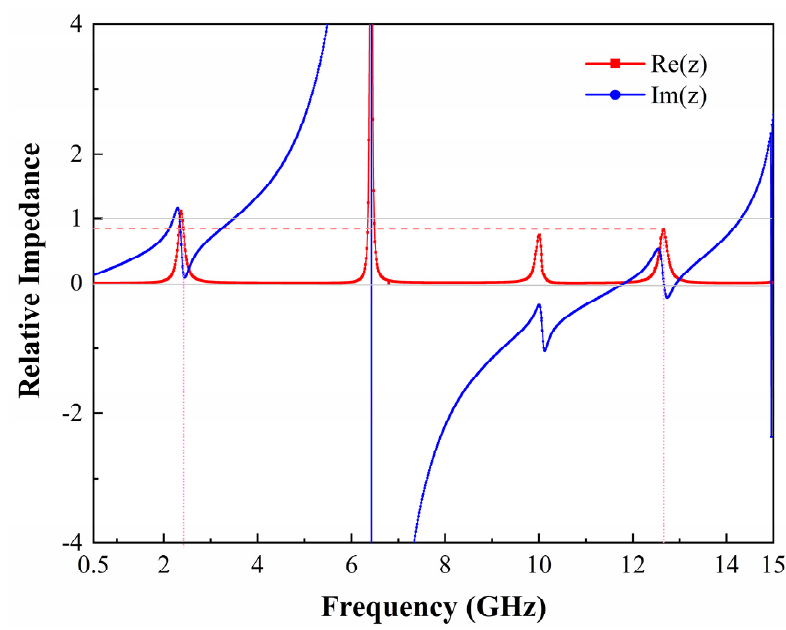
Figure 3. Simulated the real and imaginary parts of the relative input impedance of the metasurface array unit cell. array unit